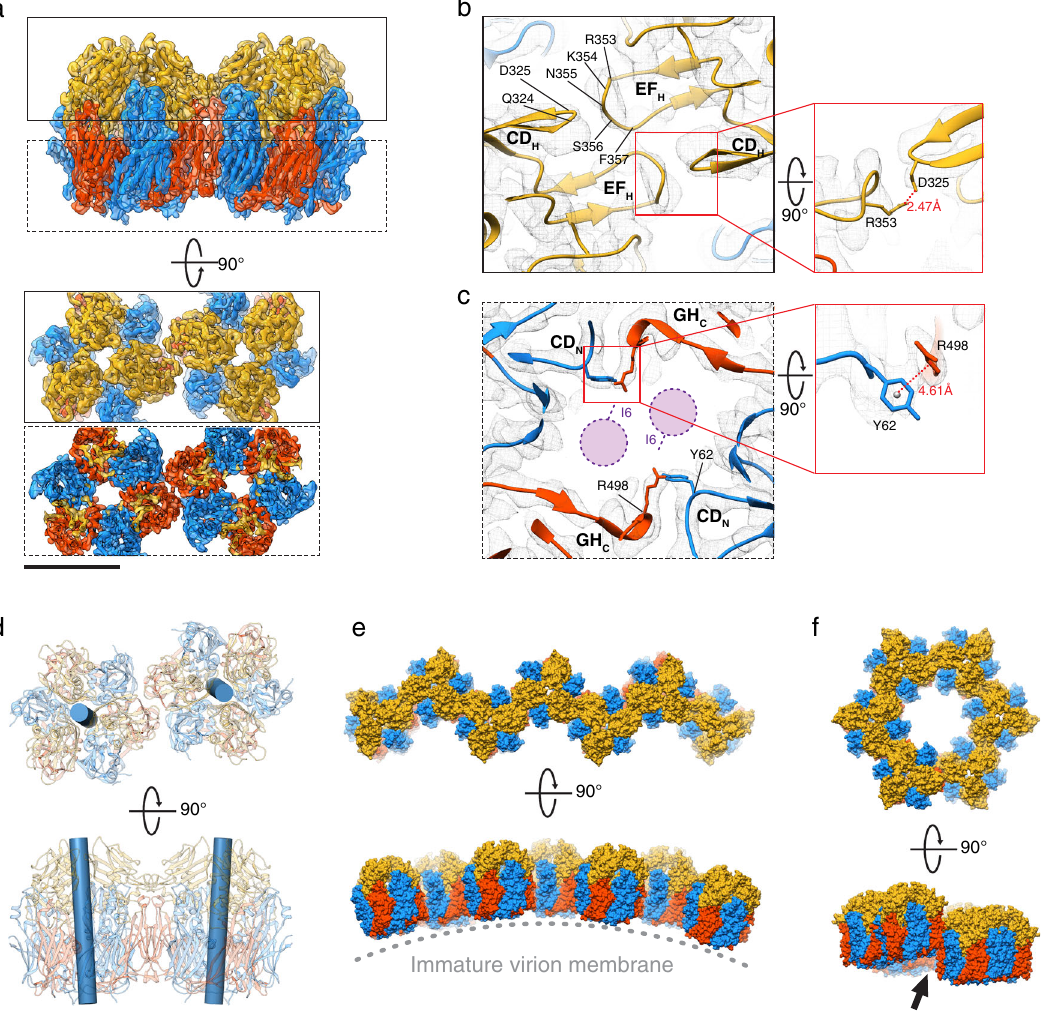
Fig. 2 Cryo-EM structures of the VACV D13 trimer doublet. a Isoelectron potential surface (contoured at 3.0 σ above average) of D13 trimer doublet with the docked molecular model. Intertrimer contacts are revealed in slabs (boxes with bold and dashed lines) extracted at different clipping planes. b Head-to- head contact between the trimers in the doublet model superposed on the cryo-EM map. A potential salt bridge interaction between R353 and D325 is shown in a magni fi ed view in a red box. c Base-to-base contact between trimers in the doublet model superposed on the cryo-EM map. Positions of the missing N-terminal tail α -helix in the doublet structure are depicted as purple circles, with its isoleucine (I6) rotamer indicated by a protruding dashed line. The cation- π interaction between Y62 and R498 is shown in the red box. d Relative position of neighboring trimers in the doublet as shown by cylinders, indicating the 3-fold symmetry axis of each trimer. The torsion angle between the axes is 8.0°. e , f Linear and planar expansions of the D13 doublet interface. The side view of the linear expansion exhibits convex curvature with the trimer base facing the center of the arch. Planar expansion results in a ring of six trimers, but the ring does not close (arrow) due to geometrical clash. Scale bars, 5